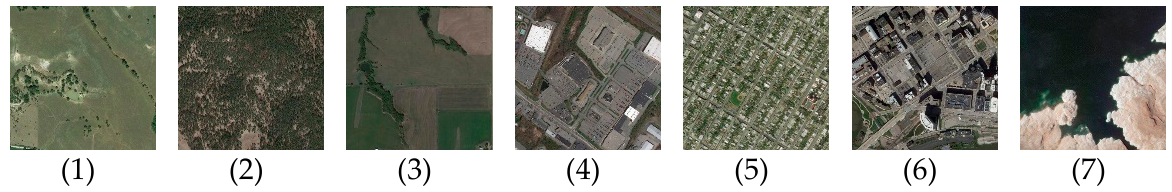
Figure 4. Examples from the RSSCN7 dataset: (1) grassland, (2) forest, (3) farmland, (4) parking lot, (5) residential region, (6) industrial region, (7) river and lake.